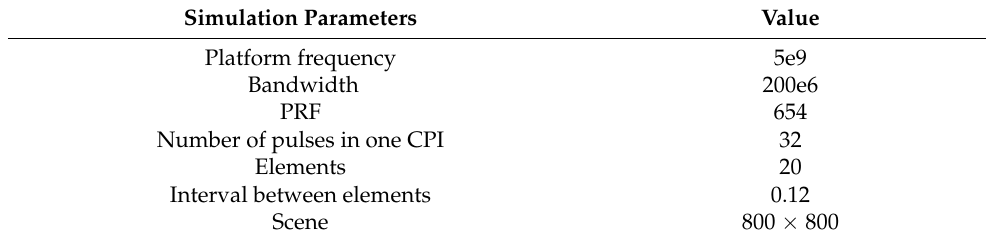
Table 2. Simulation Parameters.